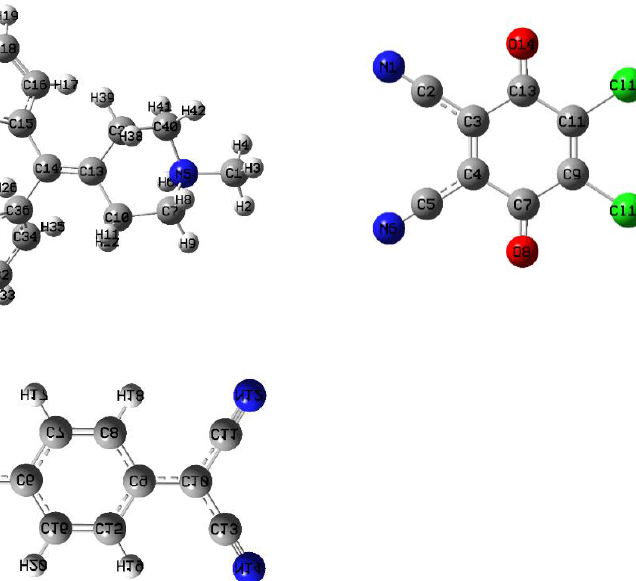
Figure 5. ( A ) The Mulliken charge and natural atomic charge distribution of the (KT–DDQ) complex and ( B ) the Mulliken charge and natural atomic charge distribution of the (KT– TCNQ) complex by the DFT/MPW1PW91 methods with a 6-311G(d, p) basis set.